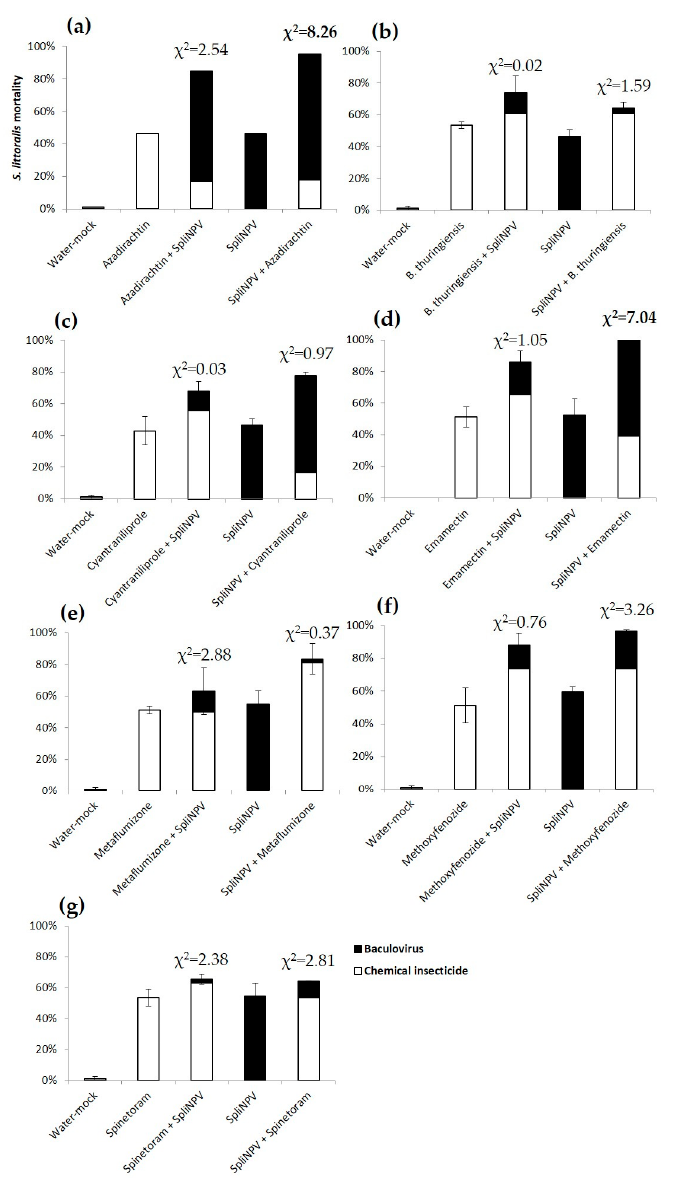
Figure 2. Cumulative daily mortality (%, mean ± SEM) of Spodoptera exigua second instar larvae provided with the LC 50 of chemical insecticides (grey solid line), ( a ) emamectin; ( b ) metaflumizone; the LC 50 of AcMNPV (black solid line) or the synergistic combination of both (gray or black dotted line) over 10 min, and then maintained ad libitum on a semi-synthetic diet. Asterisks stand for significant χ 2 , showing synergy. Insects 2020 , 11 , x FOR PEER REVIEW